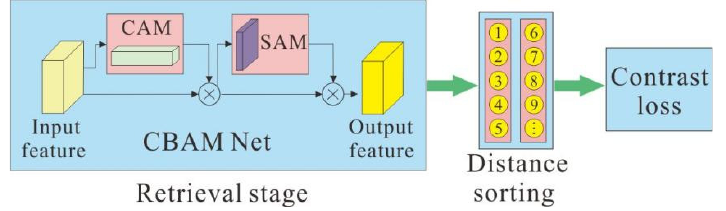
Figure 9. Integrated attention mechanism model.